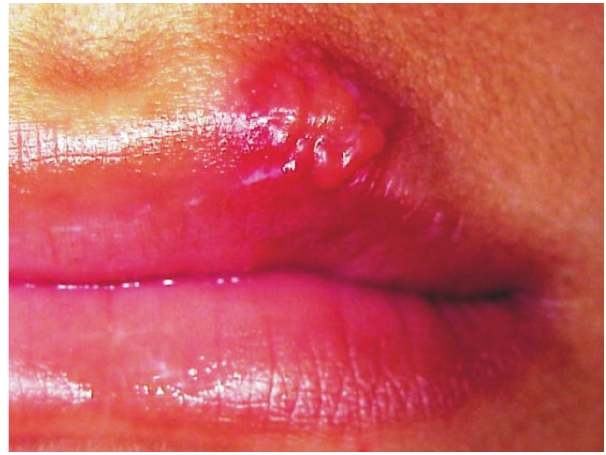
Figure 3 - Recurrent herpes labialis vesicule stage on the upper